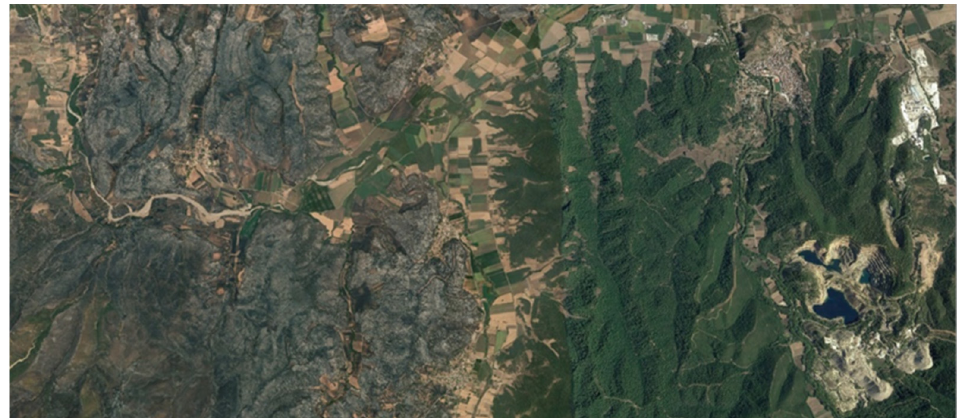
Figure 19. The flatland of Krya Vrisi (center of the figure). The area of the fire (left), forests untouched by the fire (right). Map form Google Earth [73].